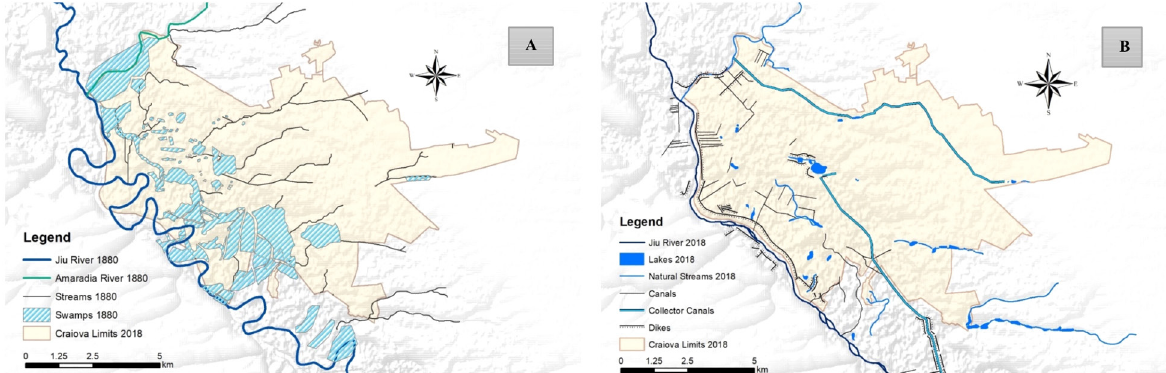
Fig. 8. The comparison of the hydrography of Craiova at the level of 1880 (a) and 2018 (B) ( albă et al. 2018) .